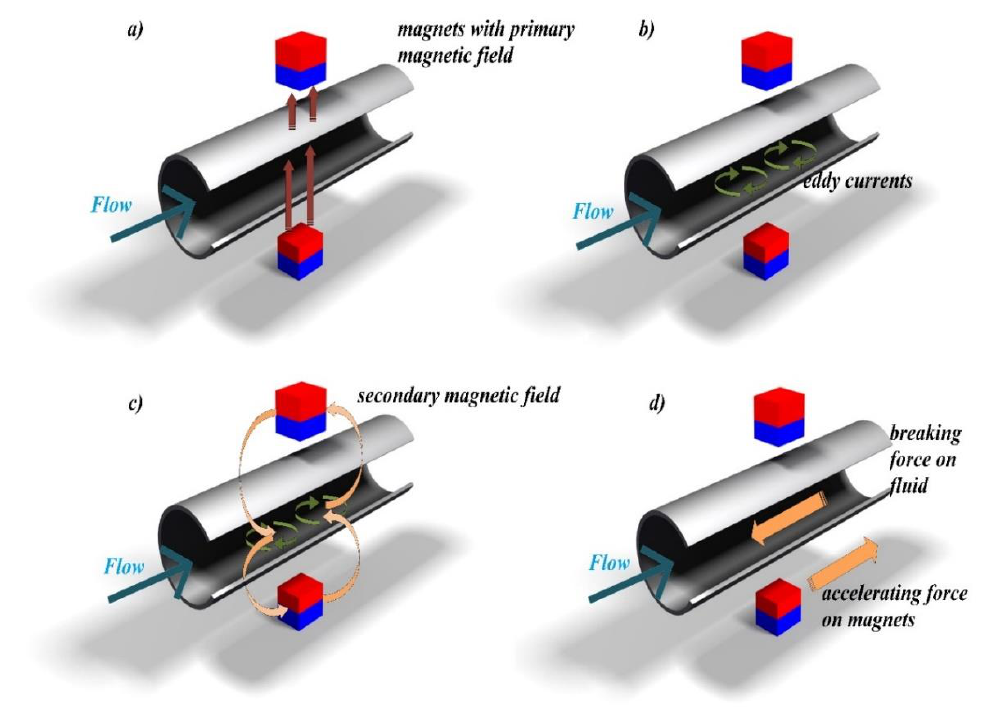
Figure 7. The Lorentz force in different arrangements of different magnetic fields [188]. ( a ) Magnets with primary magnetic field ( b ) Eddy currents ( c ) Secondary magnetic field ( d ) Breaking force on fluid.